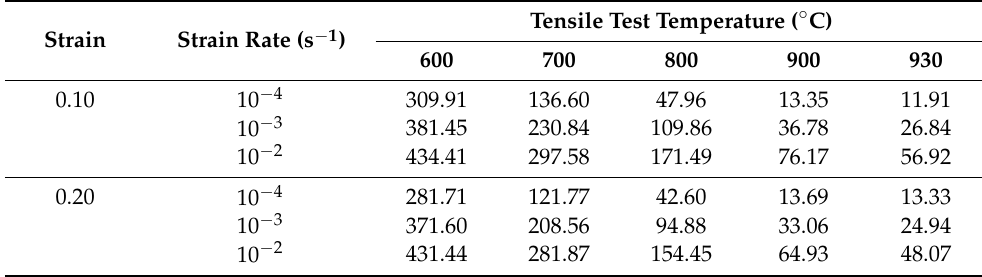
Table 2. The selected flow stresses of tensile testing for Ti-6Al-4V alloy after air cooling (MPa).